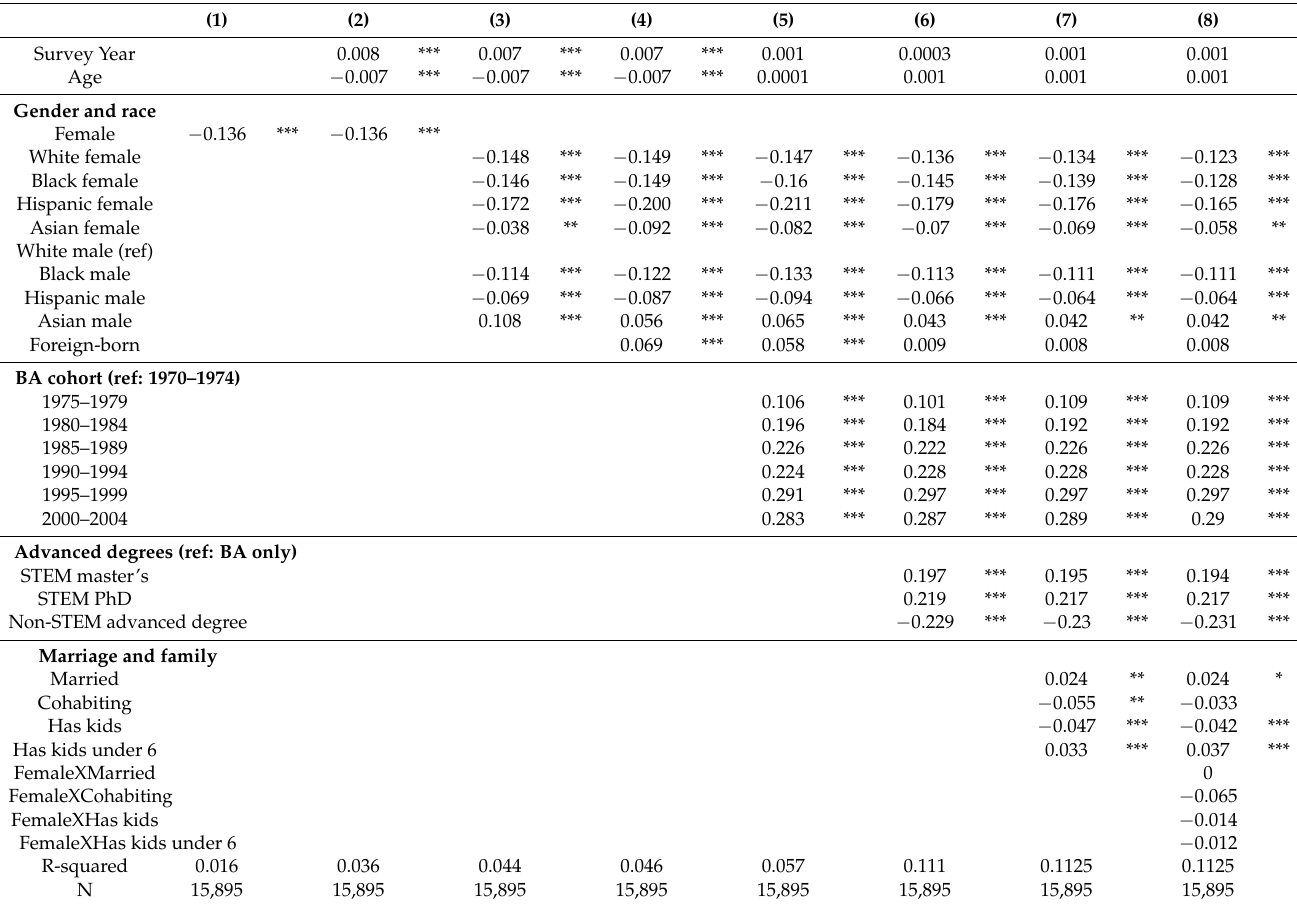
Table 2. Linear probability models predicting working in any STEM occupation: Computer science degree